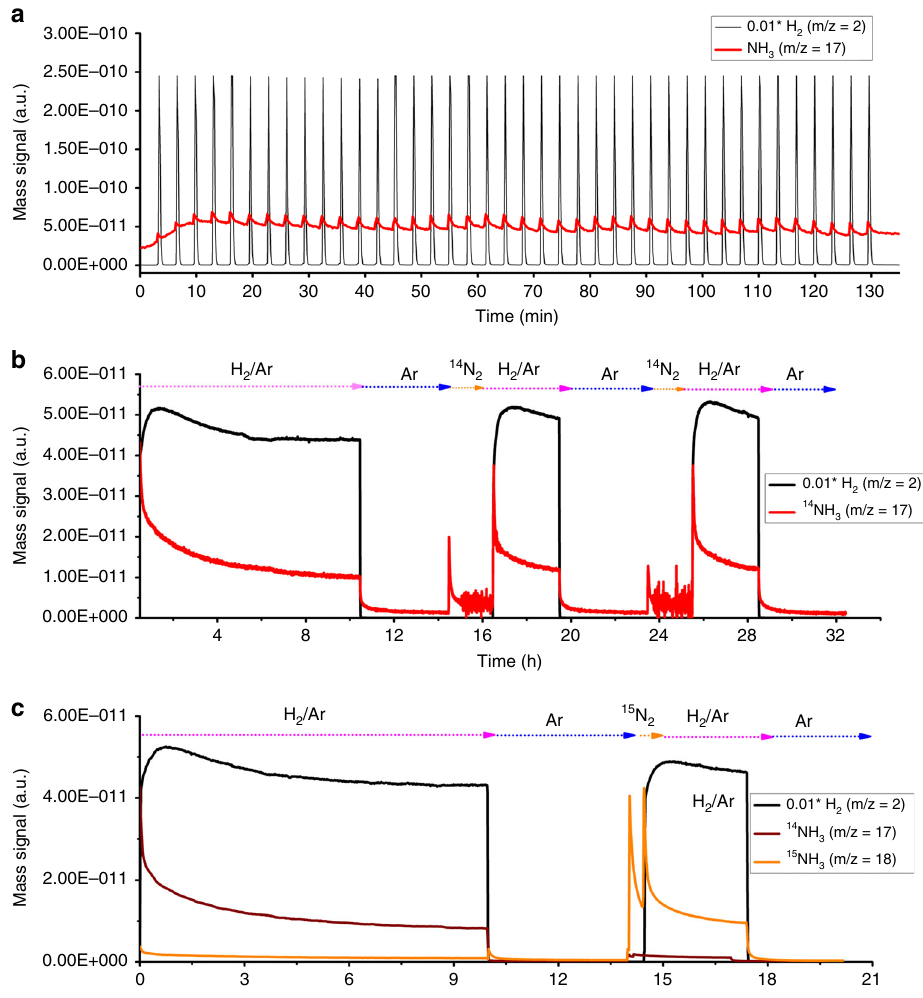
Fig. 3 Identi fi cation of N-involved chemical looping pathway. a H 2 pulse results at 350 °C, b isothermal surface reaction pro fi les; and c isothermal 15 N isotopic labeling results over Co – N – C at 350